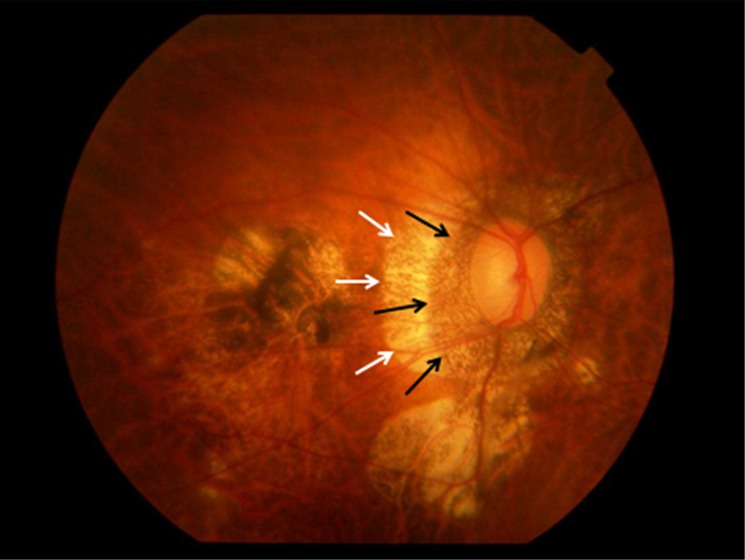
Fundus photograph of a highly myopic eye with parapapillary delta zone (black arrows) and gamma zone (white arrows).